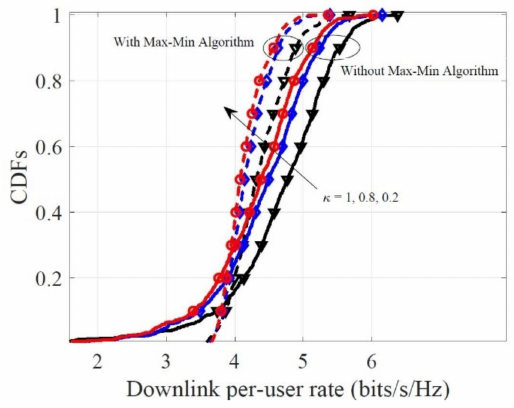
Figure 6. CDFs of the downlink per-user rate for the different κ , with M = 60, N = 10, K = 10.